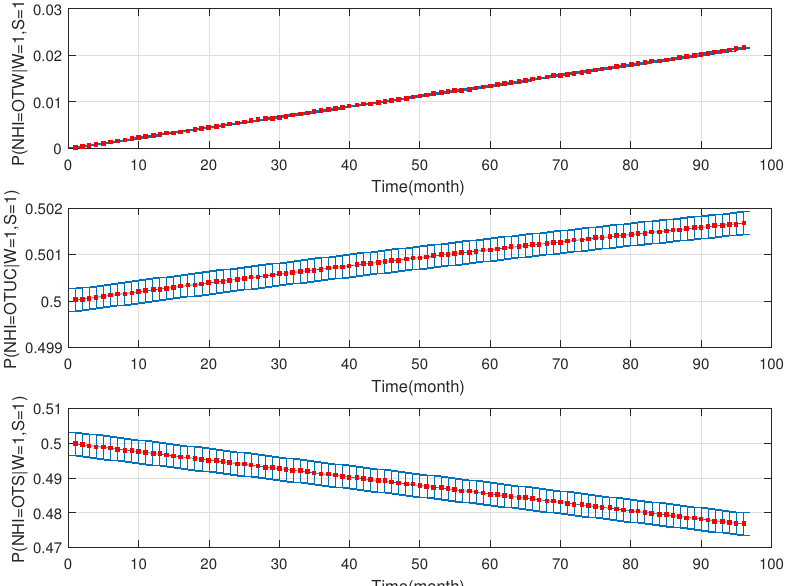
Figure 17. The probability of new herd incident (NHI) (officially TB free status withdrawn (OTW), officially TB free status unclassified (OTUC), officially TB free status suspended (OTS)) in low-risk areas of England where C: manure storage over 6 months; S: there is silage fed in the presence of the rest of risk factors (A: cattle are over 24 months; B: Badger density ≤ 3 heads/ha; D: stock density is more than 3 head/km − 2 ; and W: the number of purchased cattle is more than 50